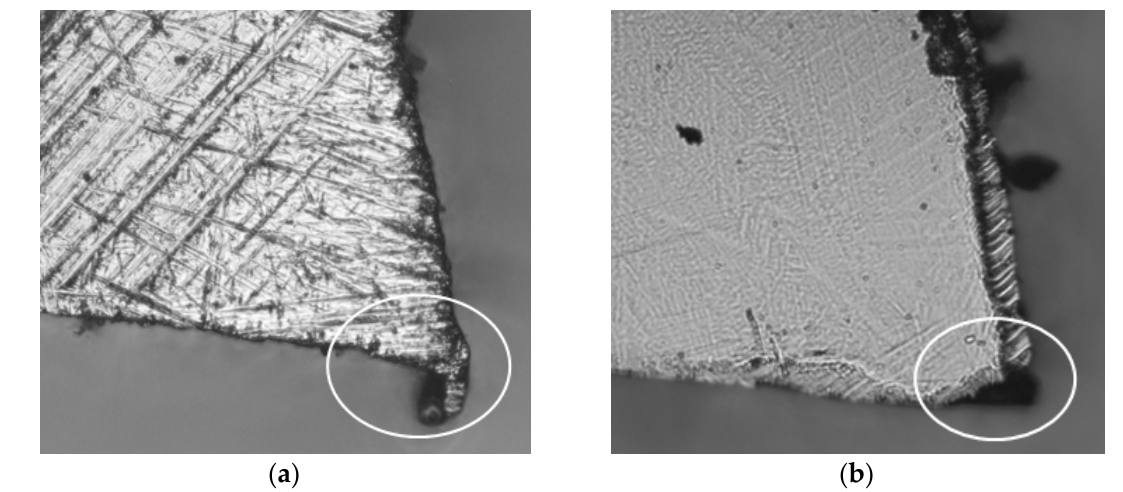
Figure 4. The teeth with larger values of the cutting edge radii, which are caused by burrs after grinding the cutting edge in a new saw blade ( a ) and by damage to the cutting edges in sharpened saw blades ( b ).